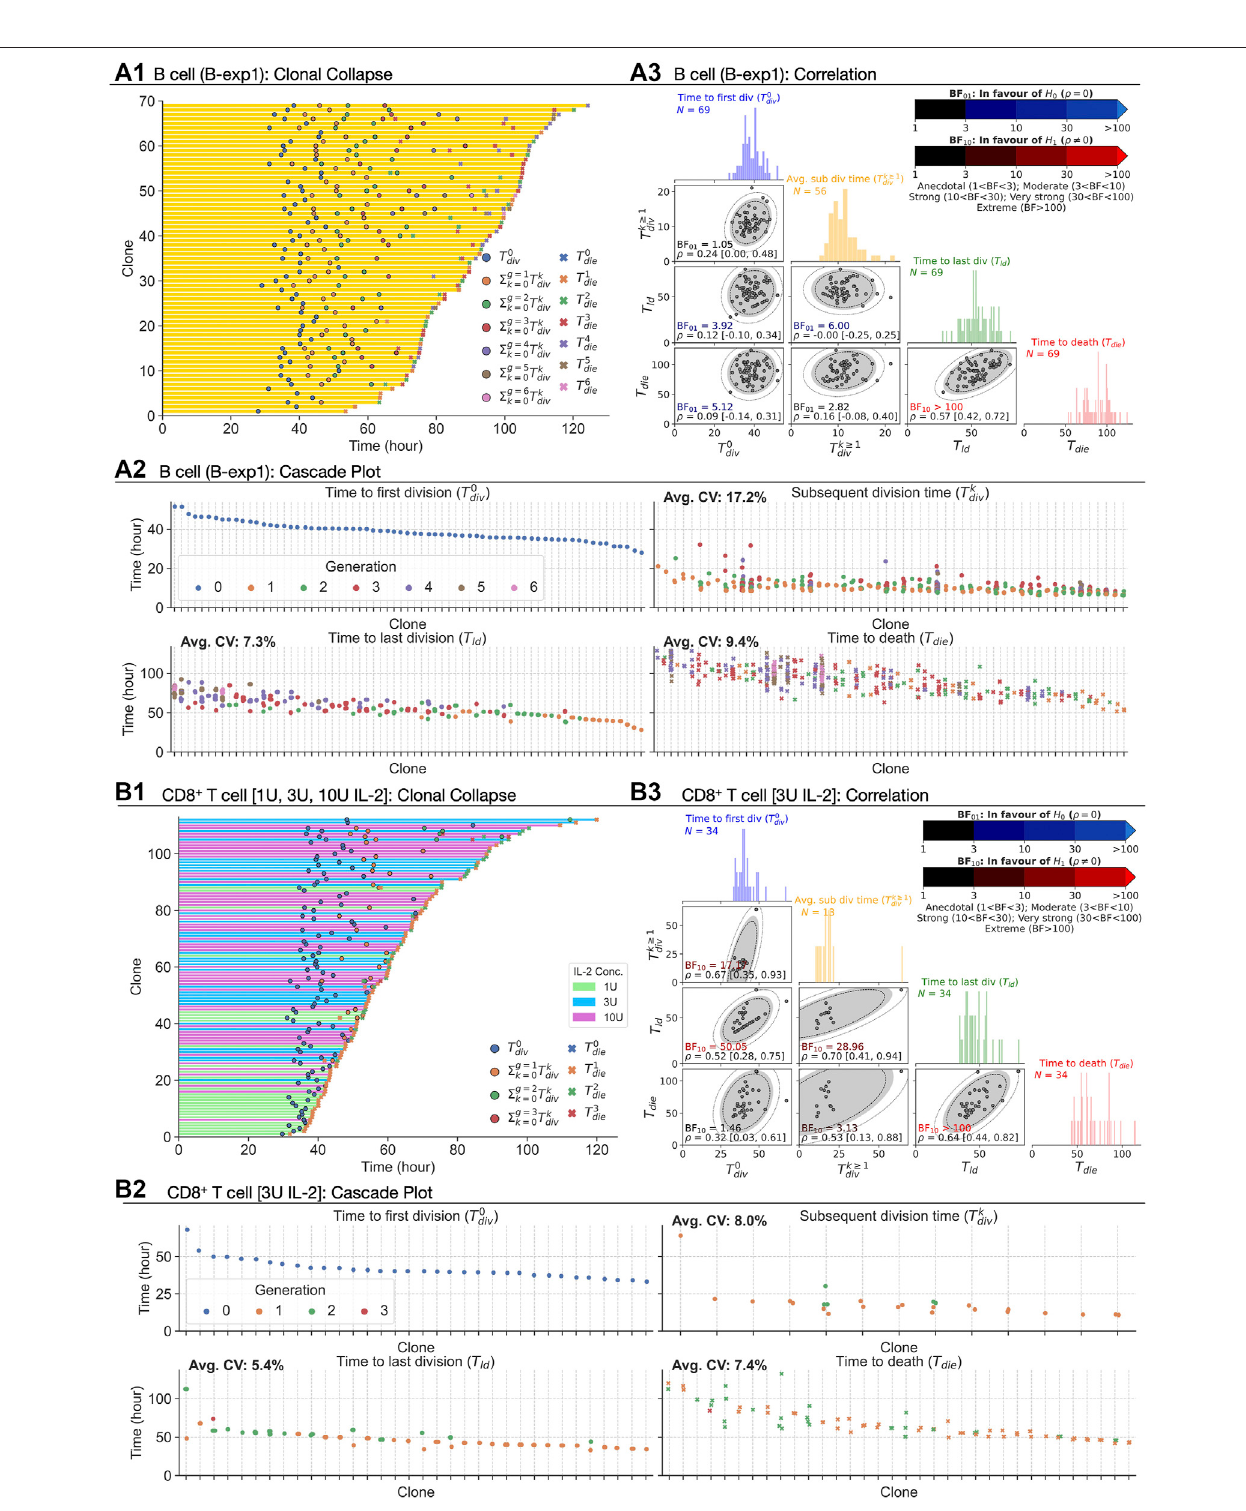
FIGURE2| ExtractingtimestofatesfromCpG-stimulatedBcellsandCD8 + Tcellsinthepresenceof1,3,or10 UIL-2. (A1,B1) ClonallycollapsedfamilytreesofB and T cells respectively. (A2, B2) Rank ordered times to events of families. (A3, B3) Correlation coef fi cient ( ρ ) estimated using bivariate normal distribution with 95% credible interval is reported for each pair. 90, 95 and 99% density regions are plotted over the data. For null, H 0 : ρ (cid:2) 0, and alternative, H 1 : ρ ≠ 0, hypotheses, Bayes Factors (BF 01 (cid:2) 1/BF 10 ) were calculated. If the data is more probable under H 0 , then it is BF 01 times more favoured than H 1 (blue-scale), and viceversa (red-scale). Distributions of the times are collated into 1 h time intervals and shown in the diagonal panels.